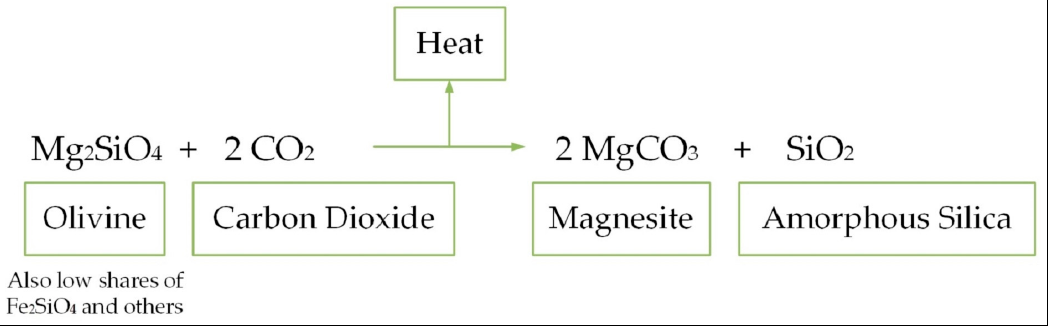
Figure 3. Formula for the exothermic reaction of olivine (forsterite) with carbon dioxide (mineral sequestration).